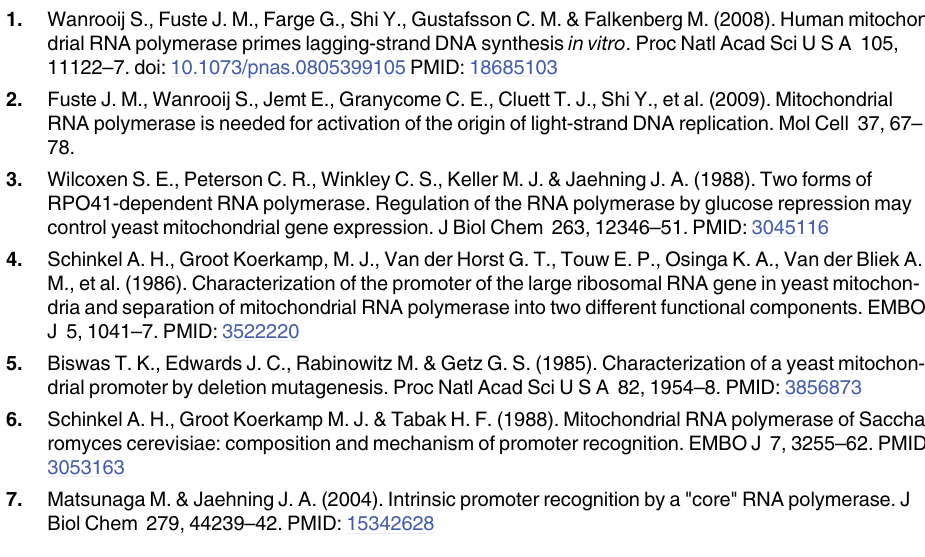
S1 Fig. Sequence comparison of T7 bacteriophage and mitochondrial RNA